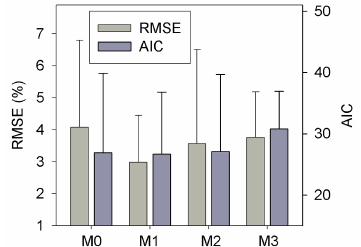
Figure 4. The RMSE and AIC of the simulated cumulative respired litter C from the four versions of litter decay model used in this study. Error bars denote the standard deviation of RMSE or AIC for different incubation experiments. M0–M3 denote the four models tested in this study (Table